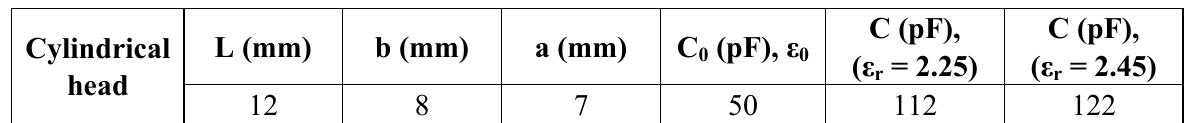
Table 2. Geometrical dimensions of sensor electrodes and expected capacitance.